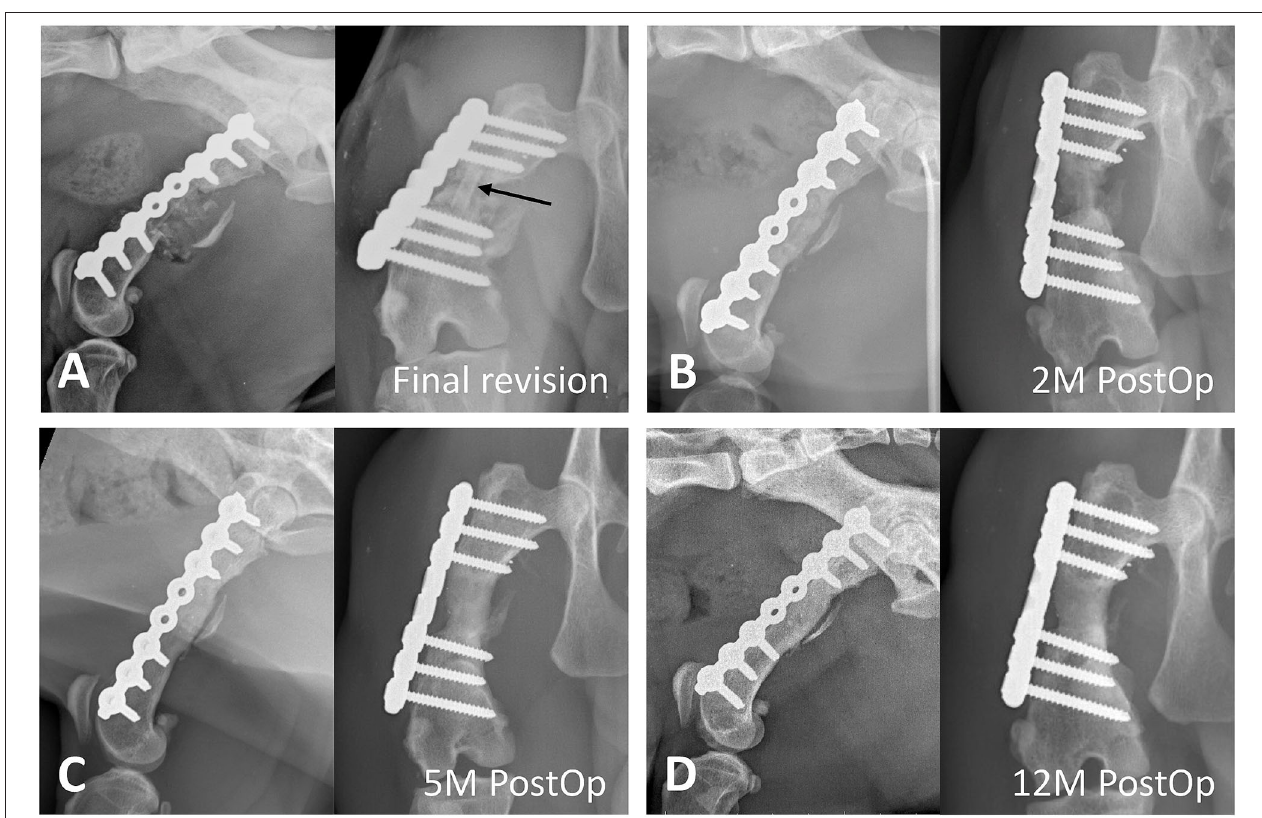
FIGURE 4 | Radiographic progression of bone fracture repair. (A) Immediately after the final revision surgery, rib (arrow) and iliac crest autografts are implanted into the bone defect, and a locking plate is applied to stabilize the fracture. Mild distal femoral varus is noted. (B) At 2 months postoperatively, bridging of the callus and resorption of the rib graft are noted. (C) At 5 months postoperatively, the bone defect shows new bone formation, and the transplanted rib graft is indiscernible. (D) At 12 months postoperatively, remodeling and maturity of the regenerated bone are